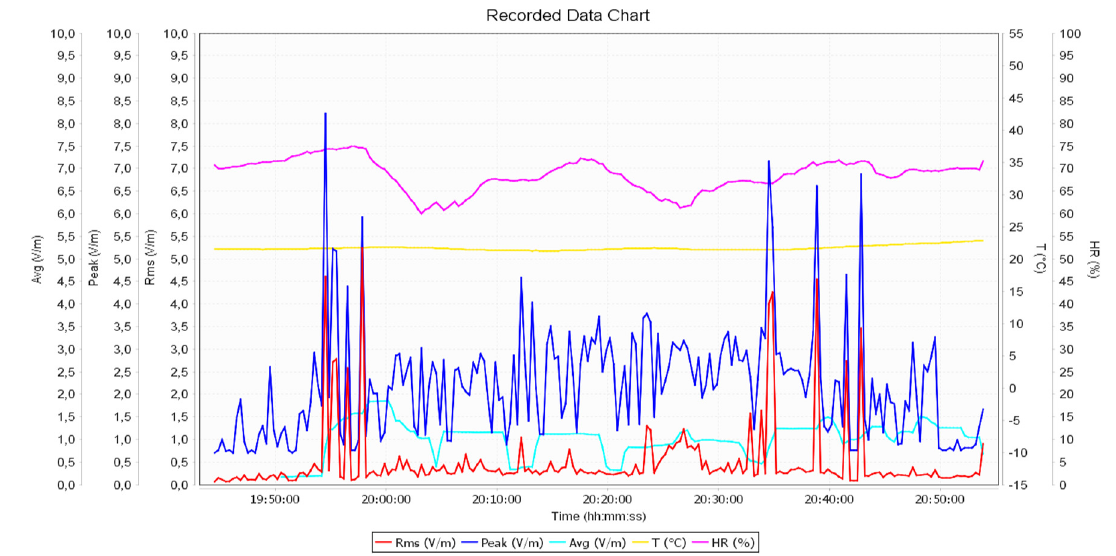
Figure 13. The intensity of the electrical component of the electromagnetic field in the course of flight no. 2 for the Robinson R44.